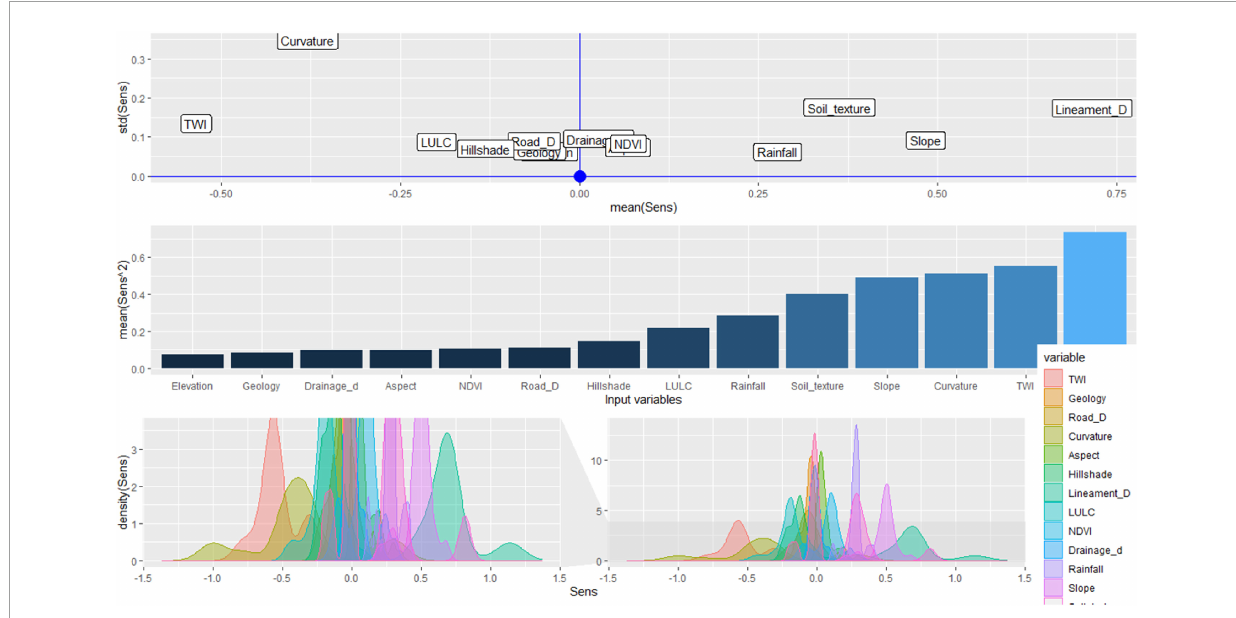
FIGURE14 Sensitivity and uncertainty analysis using deep neural network based sensitivity technique.